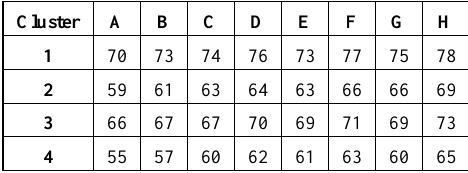
Table 3. Accuracy of aggregated